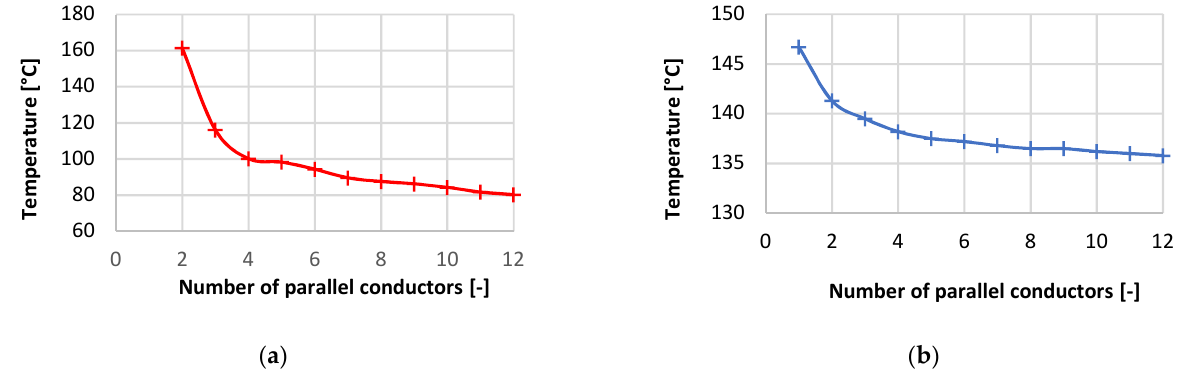
Figure 13. Results of the thermal analysis for different numbers of parallel conductors: ( a ) temperature of winding; ( b ) temperature of rotor surface.